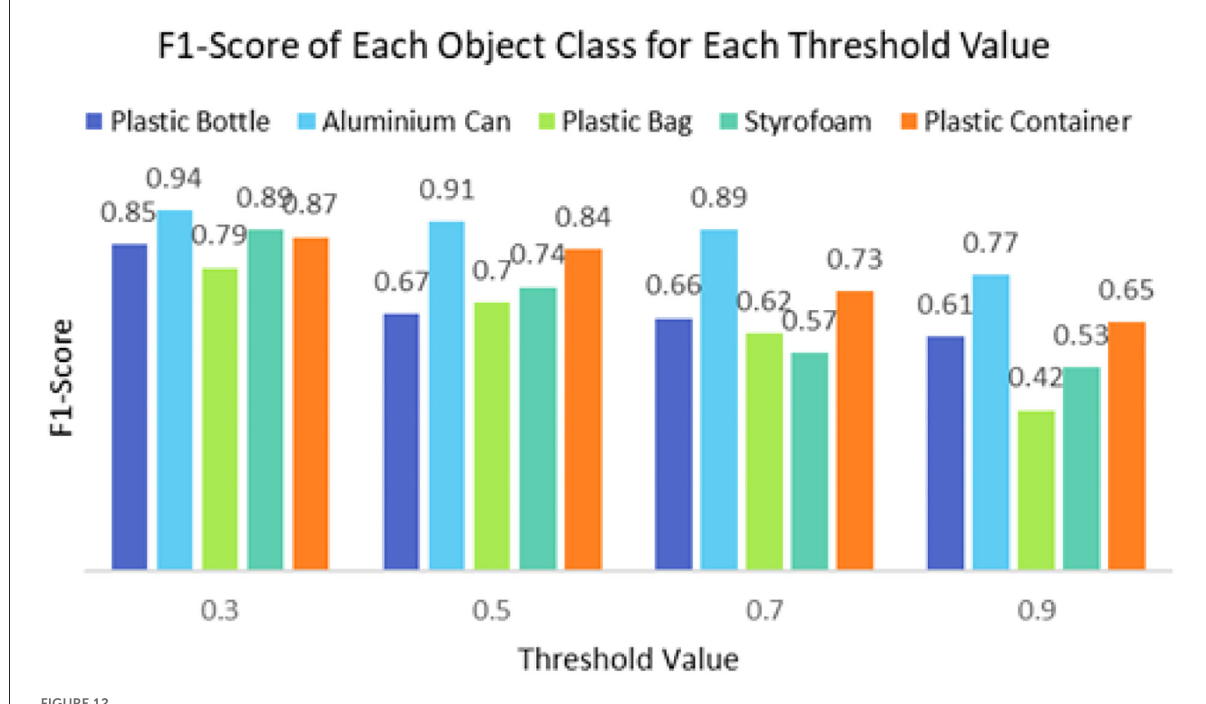
FIGURE12 The F1-score of the object detector using different threshold values.